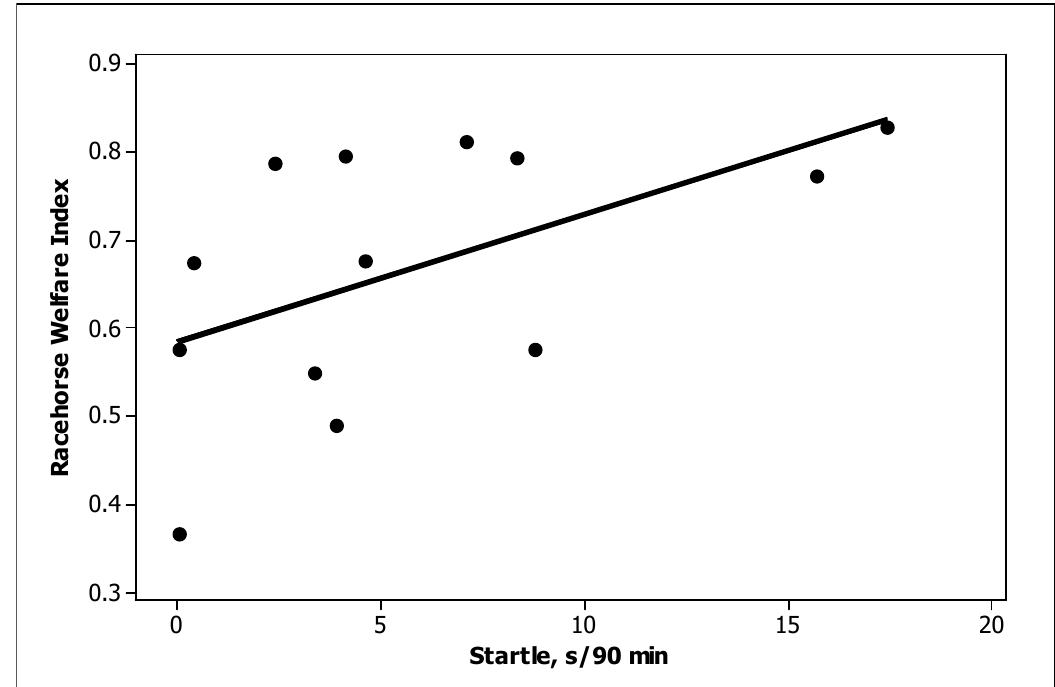
Figure 2. Negative relationship between inactivity time and the TBRWI score .